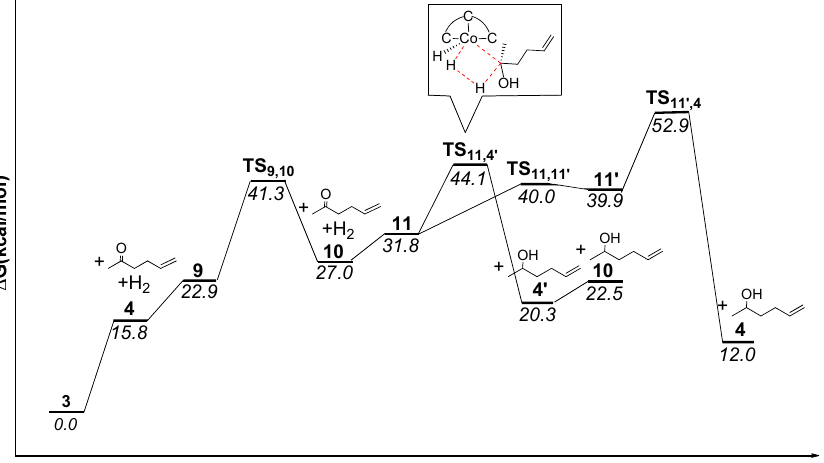
Figure 3. Free energy profile for the hydrogenation of hex-5-en-2-one to hex-5-en-2-ol catalyzed by ( Mes CCC)Co complexes.